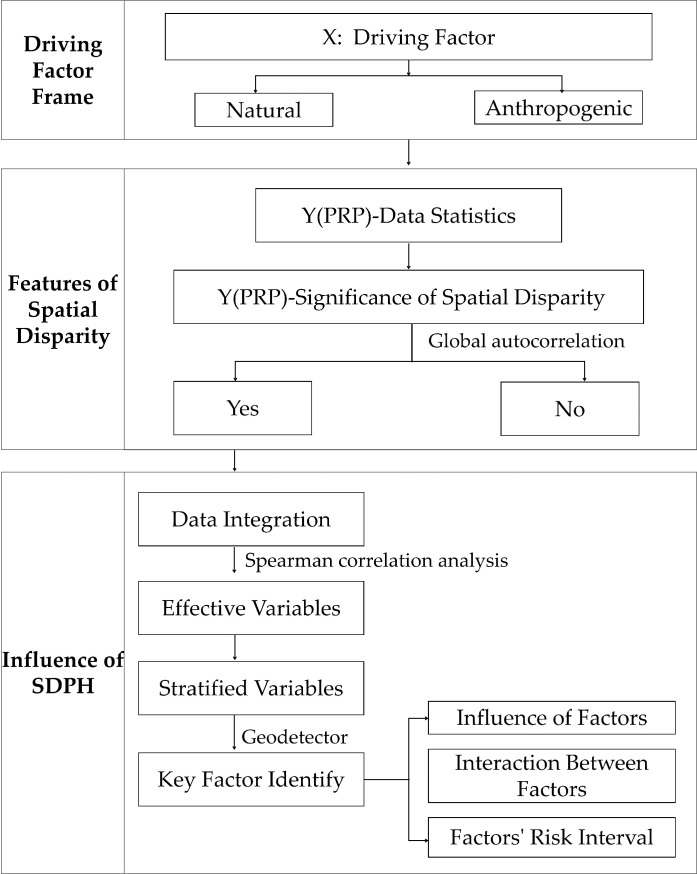
Technical route.